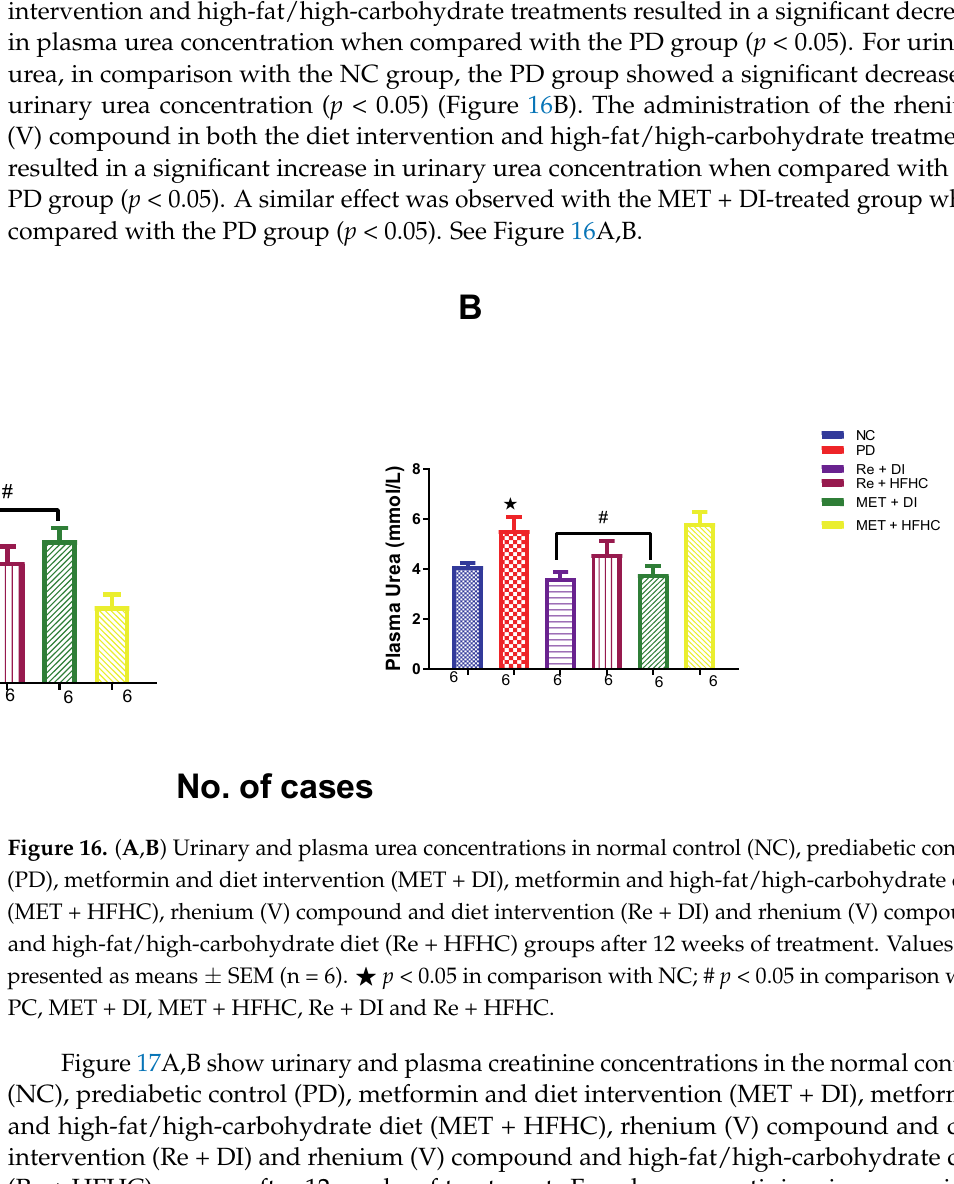
intervention and high-fat/high-carbohydrate treatments resulted in a significant decrease